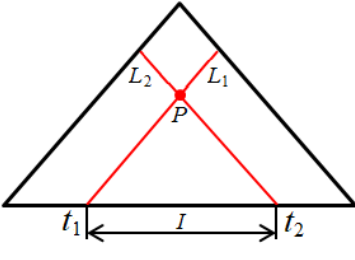
Figure 2. Illustration of the TM.